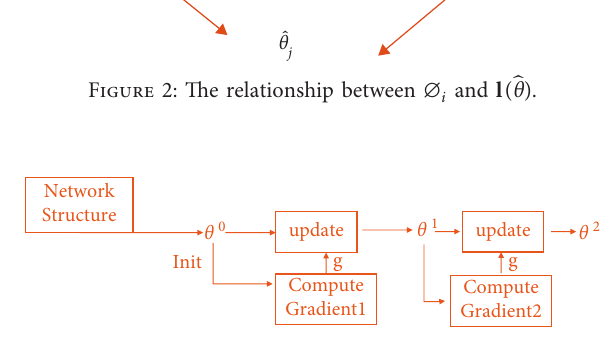
Figure 3: Gene updates in optimization processes.